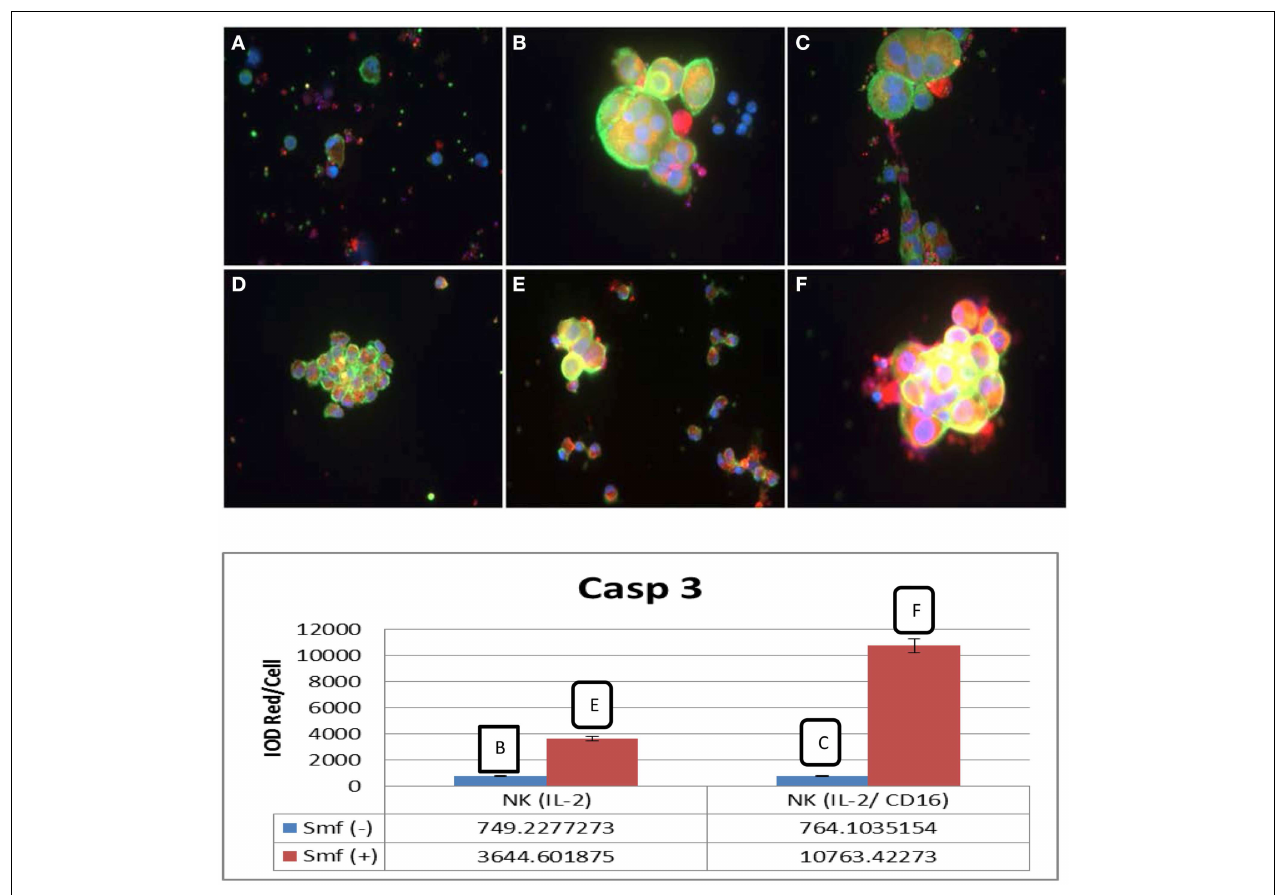
FIGURE 4 | Induction of active caspase-3 in L3.6 cancer cells by NK cells and potentiation by ω -3 and anti-oxidants. (A) NK(IL-2) cells alone; (B) NK(IL-2) cells and L3.6 cells; (C) NK (IL-2/CD16) cells and L3.6 cells, (D) NK cells with ω -3 and anti-oxidants, (E) NK(IL-2) cells and L3.6 cells with ω -3